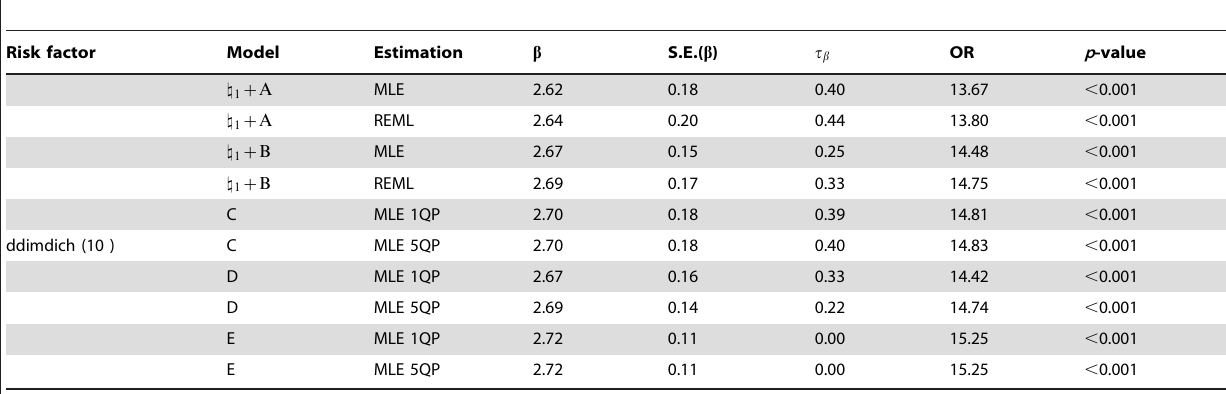
Table 3. Estimated factor-outcome associations in the DVT case study for ddimdich , adjusted for malign , surg and calfdif3 .